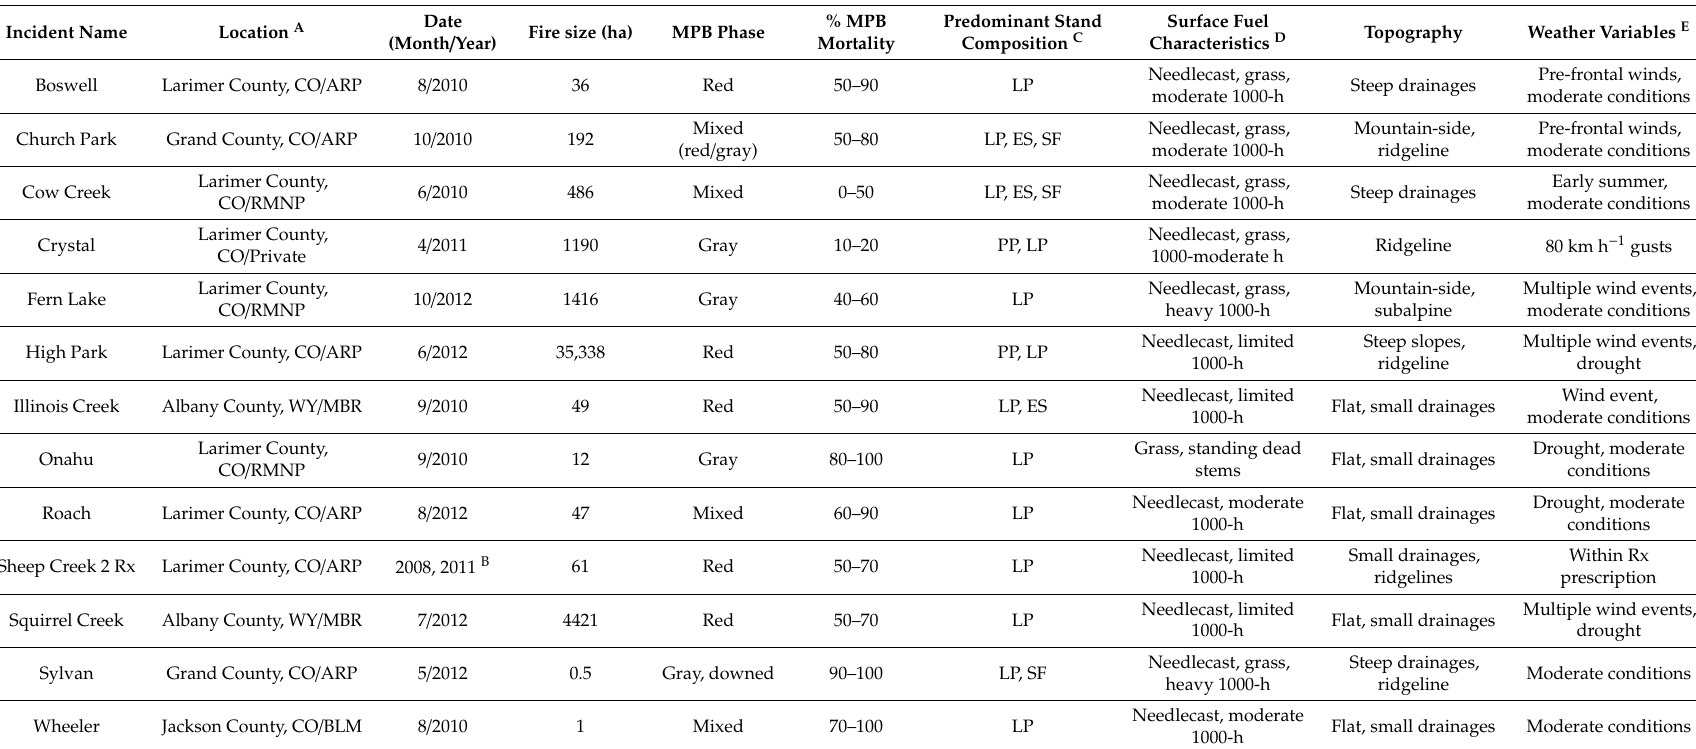
Table 1. MPB-attacked lodgepole pine forest fires encompassed by the